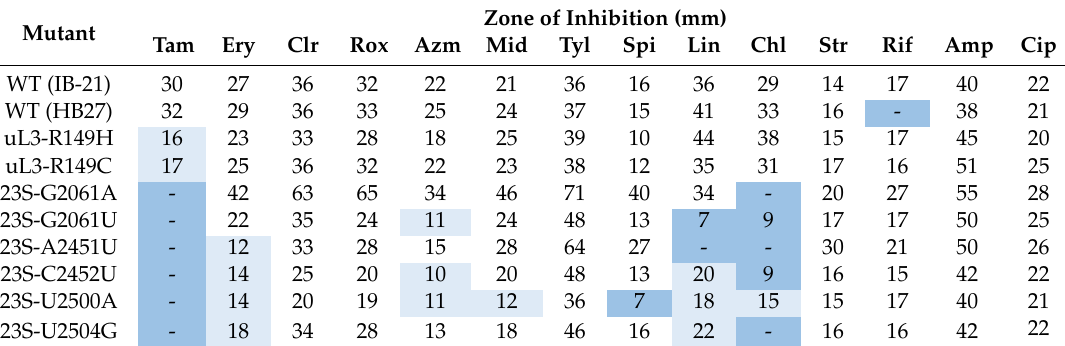
Table 2. Cross-resistance phenotypes of tiamulin-resistant mutants. Zone of Inhibition